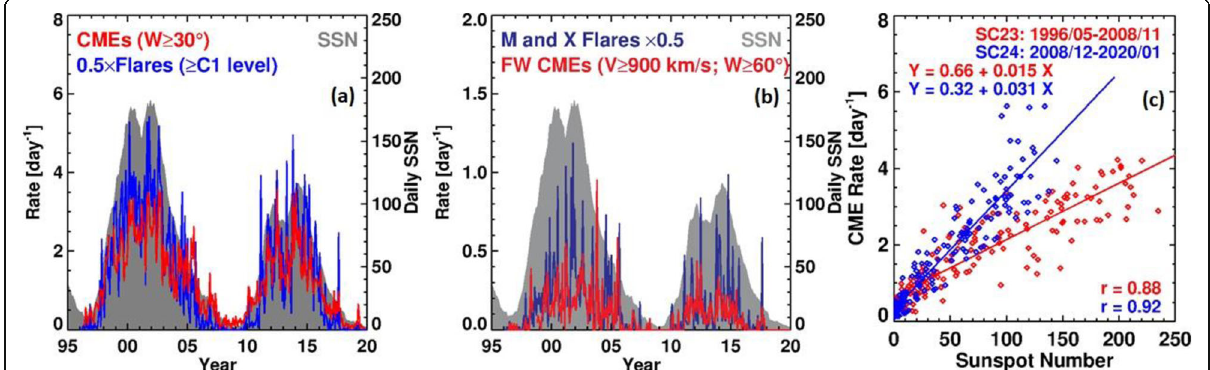
Fig. 5 Solar cycle variation of eruptive phenomena (flares and CMEs): a daily CME rate for the general population (width ≥ 30°) in red and the number of soft X-ray flares with size ≥ C1.0 in blue, b fast and wide CMEs (speed ≥ 900 km/s; width ≥ 60°) in red and major (M- and X-class) soft X-ray flares in blue, and c scatter plots between the sunspot number (SSN, V2.0) and the daily CME rate (general population) for cycle 23 (red) and 24 (blue). In ( a ) and ( b ), SSN is shown in gray background. The CME and flare rates are averaged over the Carrington rotation (CR) periods. The flare rates are multiplied by 0.5 to fit the scale. Updated from Gopalswamy et al. (2020a); Gopalswamy et al.